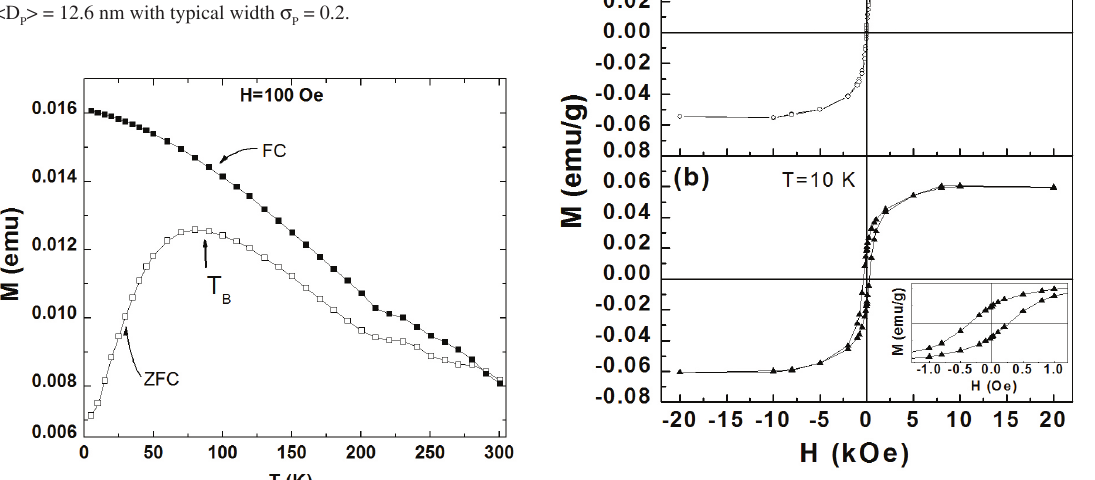
Figure 5. Magnetization as a function of magnetic field at temperatures of 150 K (a) and 10 K